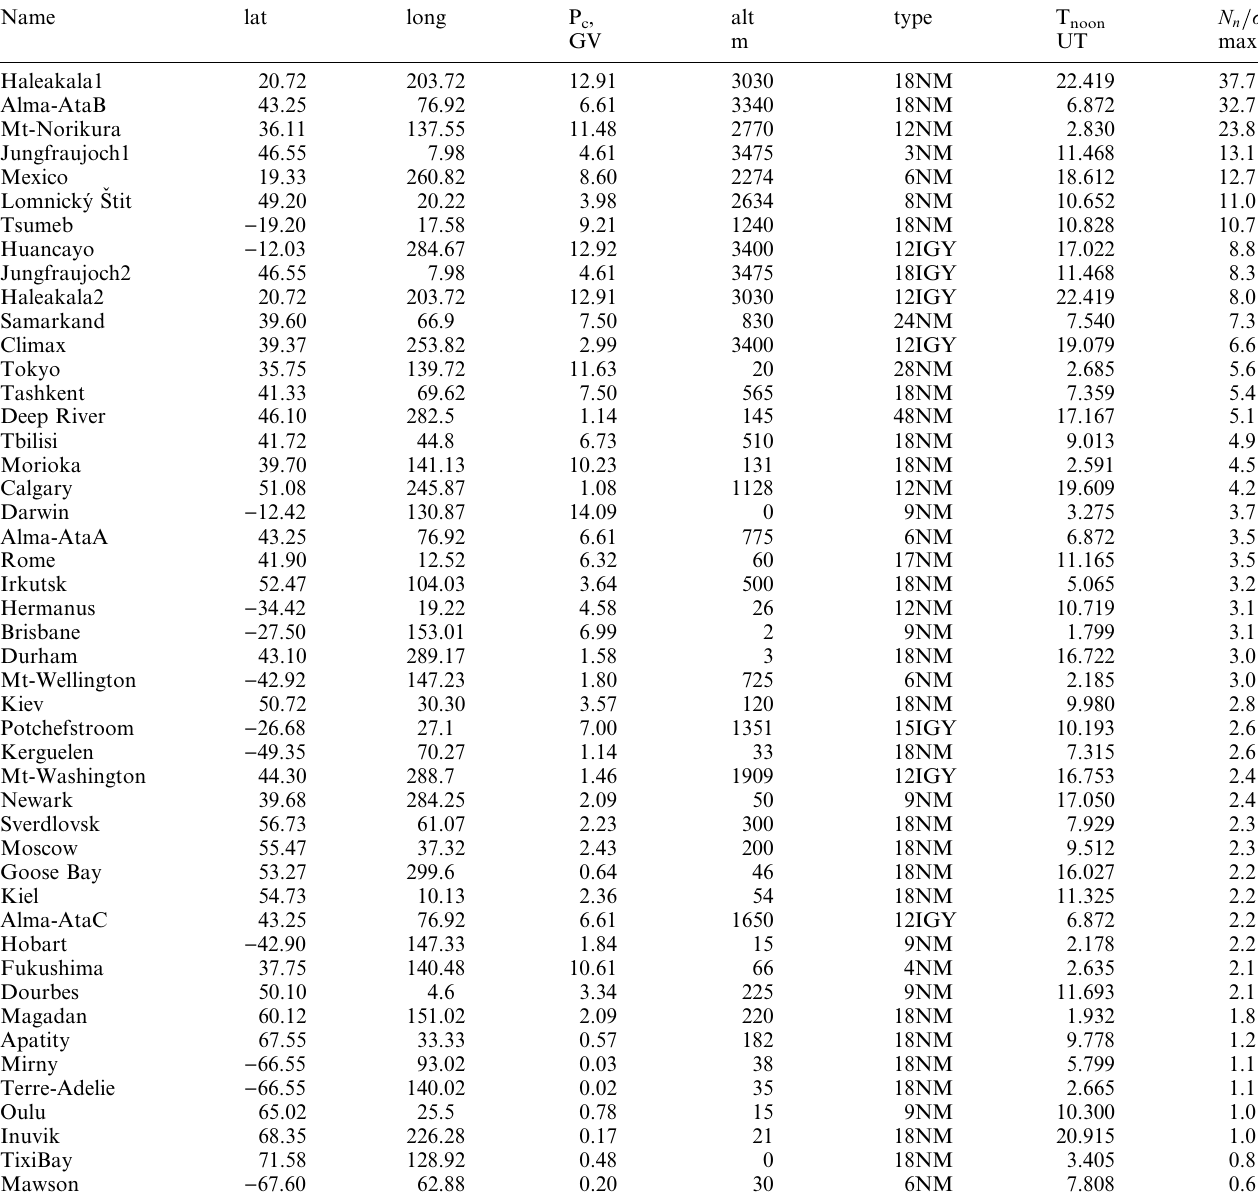
Table 2. The list of neutron monitors ordered according to their ability to detect solar neutrons Name lat long P c , alt type T noon N n = (cid:114) GV